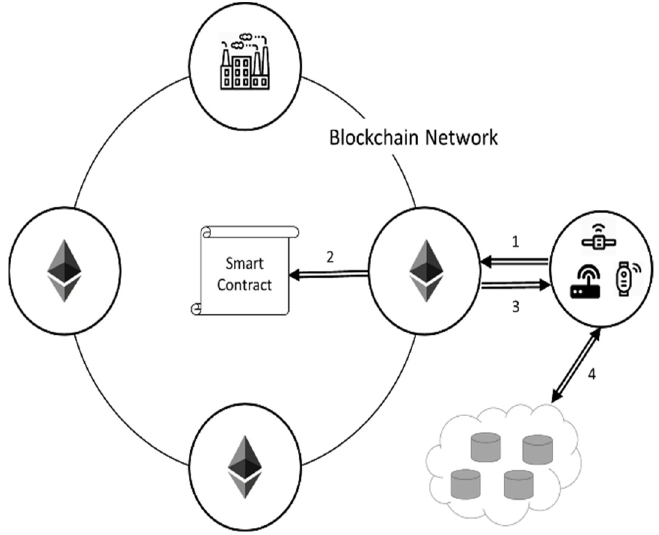
Figure 5. Firmware update file